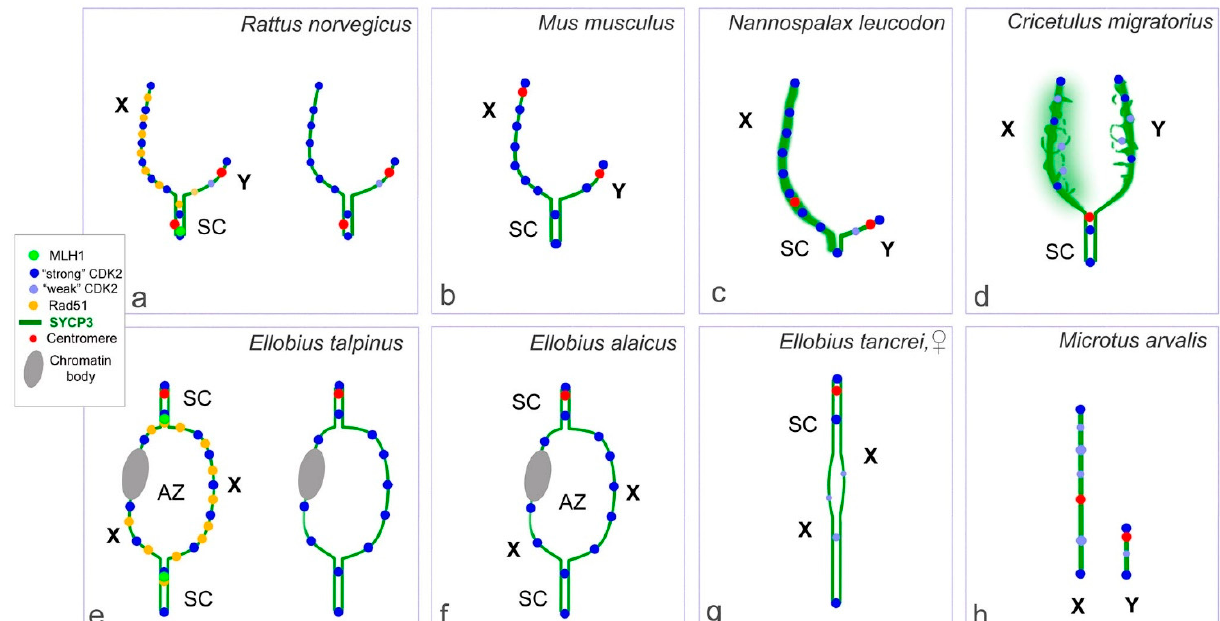
Figure 6. Schemes of CDK2 localization in pachytene sex chromosomes of the eight species of rodents. CDK2, RAD51, and MLH1 distributions are shown for males of Rattus norvegicus ( a ) and Ellobius talpinus ( e ). CDK2 distributions is shown for males of Mus musculus ( b ) ; drawn based on previous studies [19,50–52]), Nannospalax leucodon ( c ), Cricetulus migratorius ( d ), Ellobius alaicus ( f ), Microtus arvalis ( h ), and females of Ellobius tancrei ( g ). In rat and mole voles sex bivalents, colocalization of MLH1 and CDK2 signals and close localization of RAD51 and CDK2 foci in synaptic segments, and different patterns of RAD51 and CDK2 foci in asynaptic parts are shown (a, e).